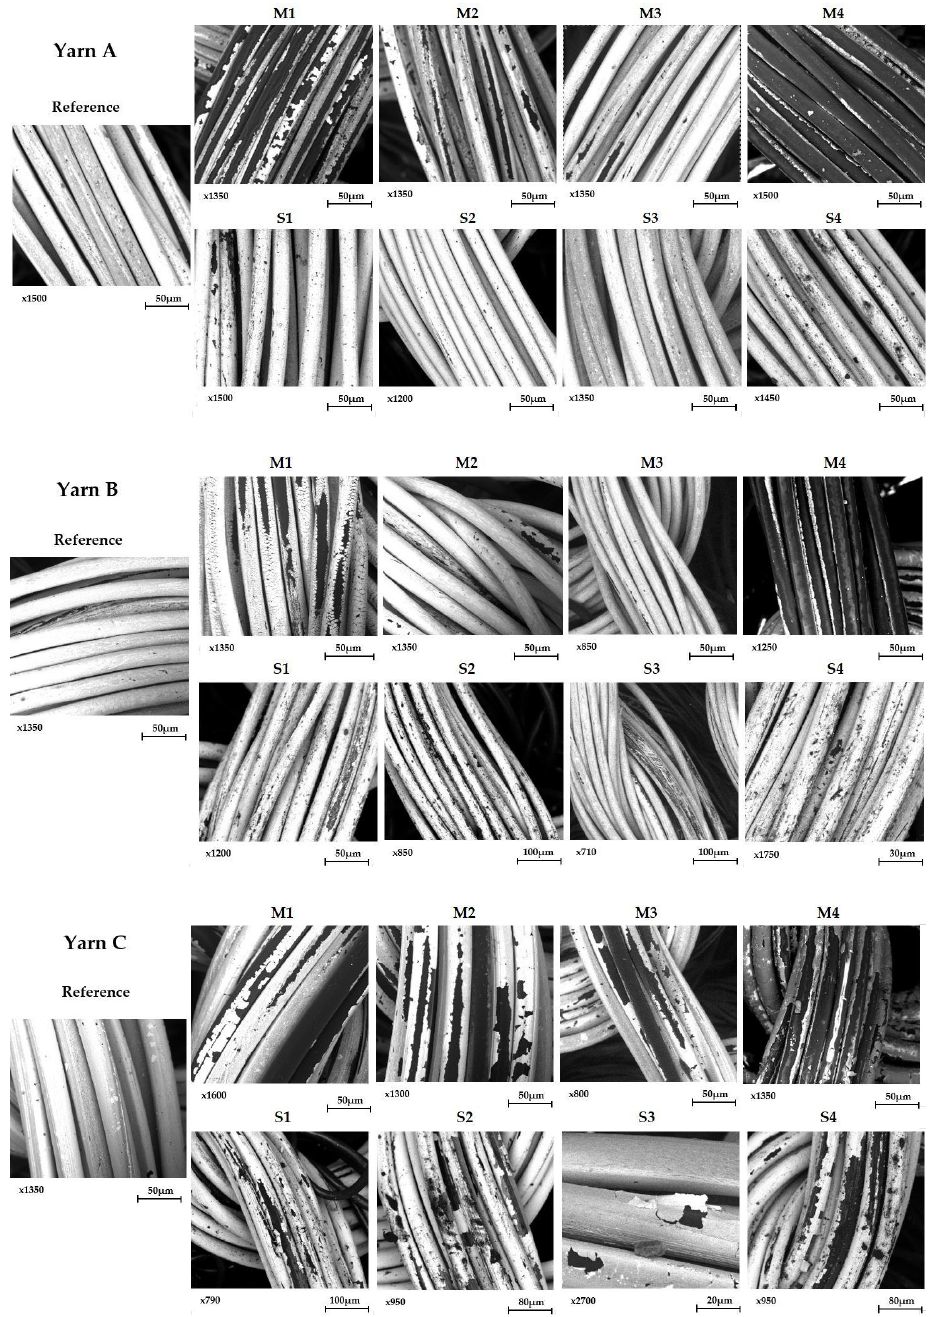
Figure 9. SEM observations of the electrodes made with Yarn A ( top ), Yarn B ( middle ) and Yarn C ( bottom ) for all the sublots. ( bottom ) for all the